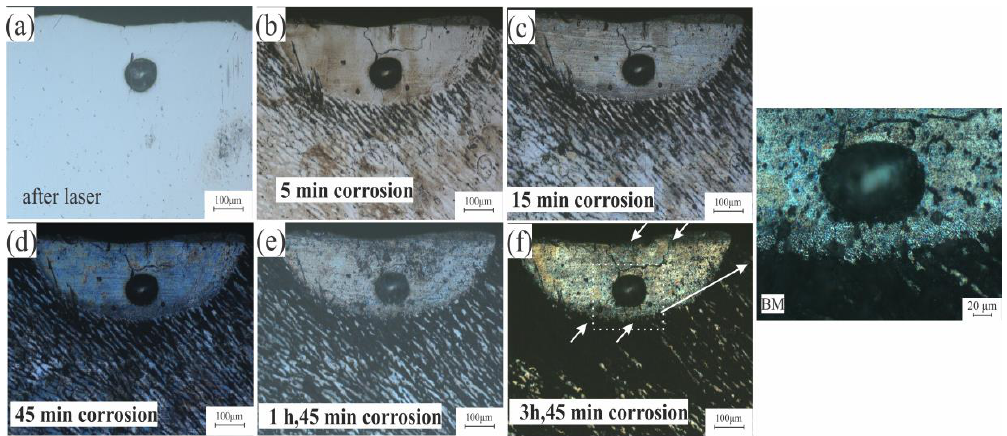
Figure 12. Intergranular corrosion of AA7075-Standard after ( a ) laser, ( b ) 5 min, ( c ) 15 min, ( d ) 45 min, ( e ) 1 h and 45 min, and ( f ) 3 h and 45 min.